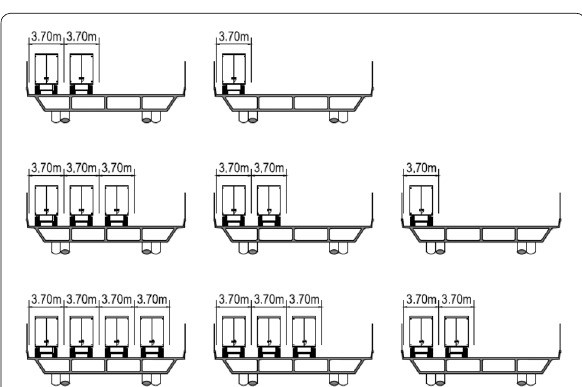
Fig. 8 HL-93 truck loading cases in the transverse direction of bridge.